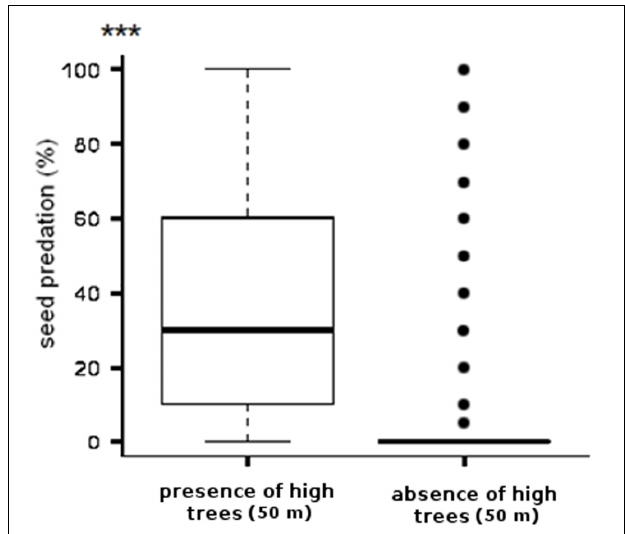
FIGURE 5 | Percentage of seed predation in the field margins presented in boxplots (median, upper and lower quartile, maximum, minimum, and outliers) of two different categories; fields with high trees or fields without high trees within a radius of 50m. For statistics see Table 2 . ∗∗∗ p < 0 .